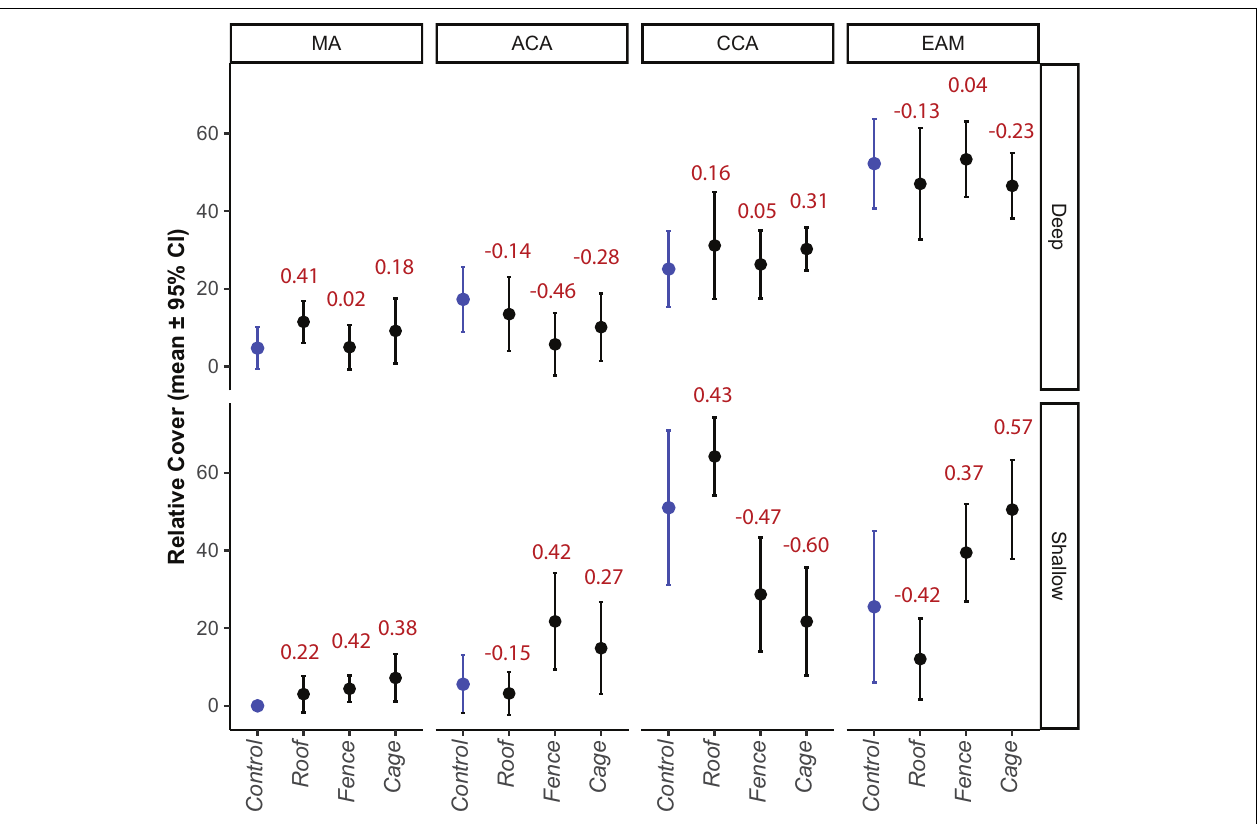
FIGURE 5 | Relative cover (mean ± 95% confidence interval) and effect size (control × treatments, values in red) of dominant groups of algae by the end of the experimental period (205 days) according to depth stratum and treatment levels in rocky shores from Arraial do Cabo (RJ, Brazil). MA = macroalgae, CCA = crustose coralline algae, ACA = articulated coralline algae, EAM = epilithic algal matrix. Shallow = 1–2 m, Deep = 5–6 m.